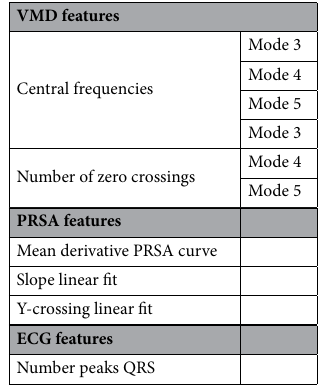
Table 3. List of features extracted from each